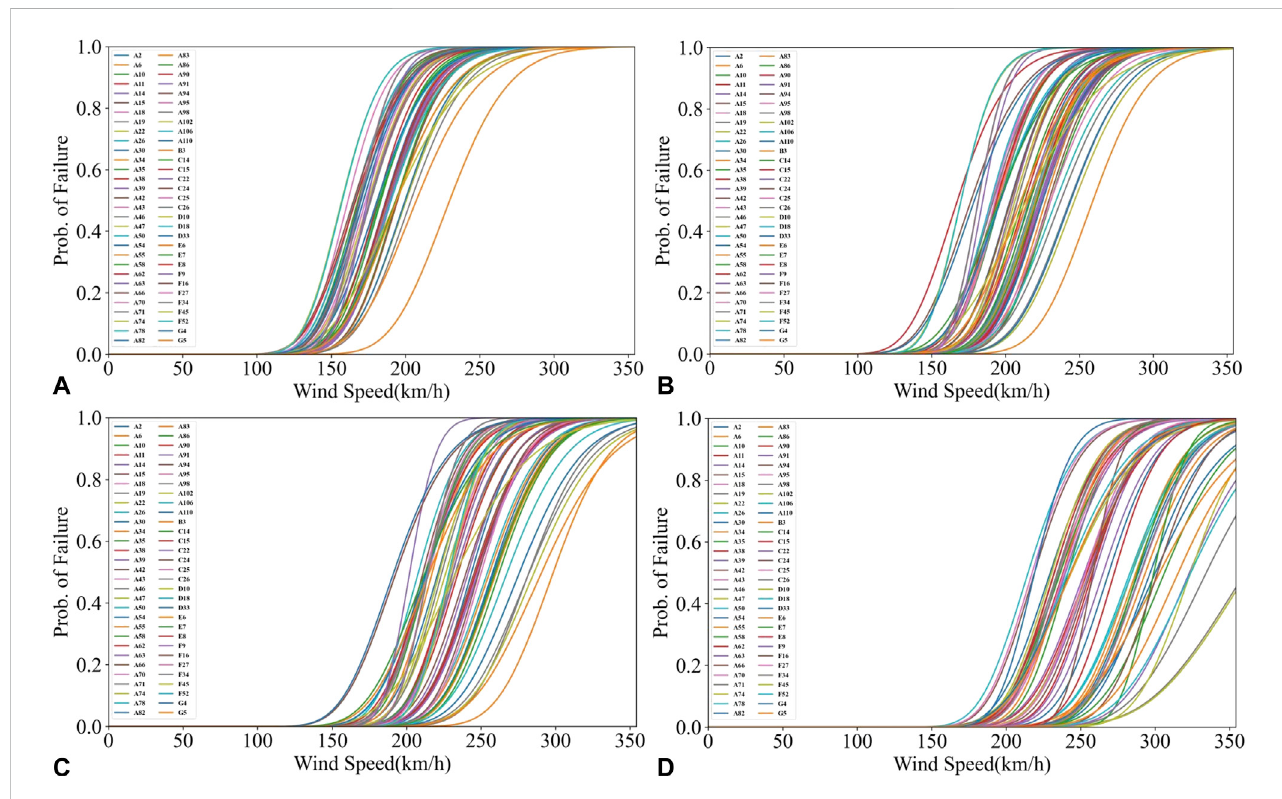
FIGURE 8 Building fragility curves for damage state: (A) minor, (B) moderate, (C) severe, and (D)